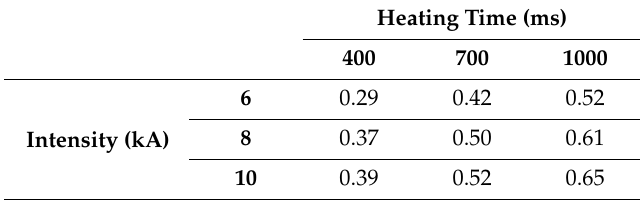
Table 2. STE values (expressed in kJ / g) for the di ff erent MF-ERS